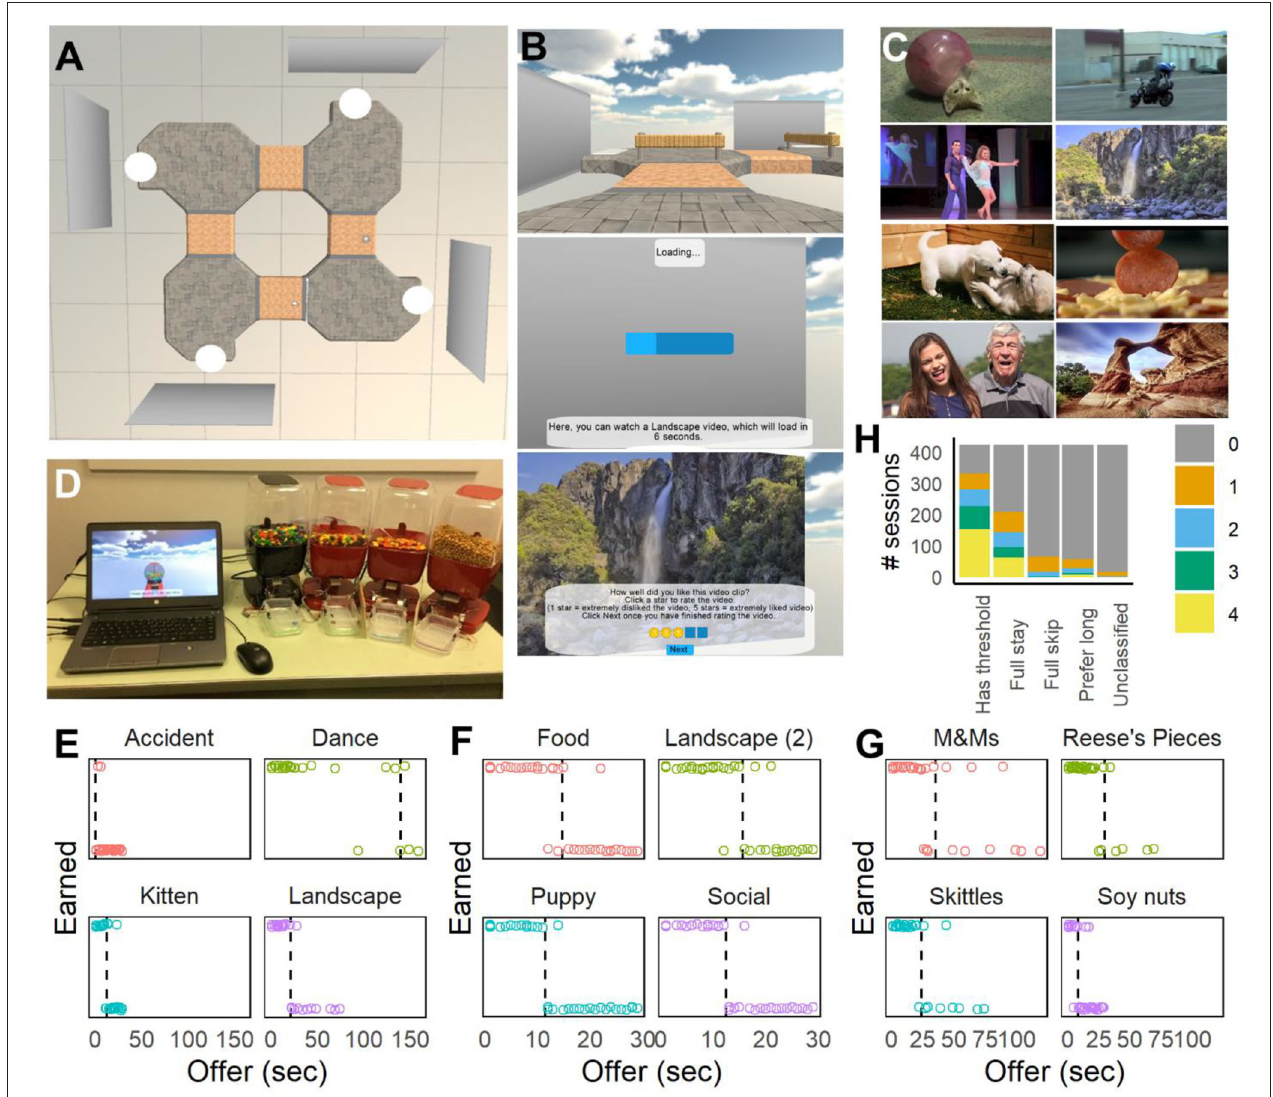
FIGURE 1 | Virtual navigation tasks and choice behavior. (A) Overhead view of the Movie Row track used after Version 1. Four movie screens were used, each displaying a different type of video clip. (B) First-person screenshots taken during the task, showing navigation between offer zones ( top ), loading bar as the participant waits for an offer ( middle ), and showing the post-video rating after a video clip is played ( bottom ). (C) Examples of movies used in the Movie Row task from the Web-Surf task ( top : kittens, accidents, dancing, and landscapes) and a second set ( bottom : puppies, food, social, landscapes). (D) Setup for the Candy Row task and food dispensers. Movie screens in the task were replaced with virtual candy (gumball) dispensers. (E–G) Examples of choice behavior for one participant (DDR035) tested on the Movie Row task with the original (E) and new (F) videos, and on the Candy Row task (G) . Sessions from (E,G) were done in the lab, and the session from (F) was done by the participant online. (H) Distribution of the types of responding (number of delay thresholds, full-stay or full-skip behavior and preferences for long delays) across the